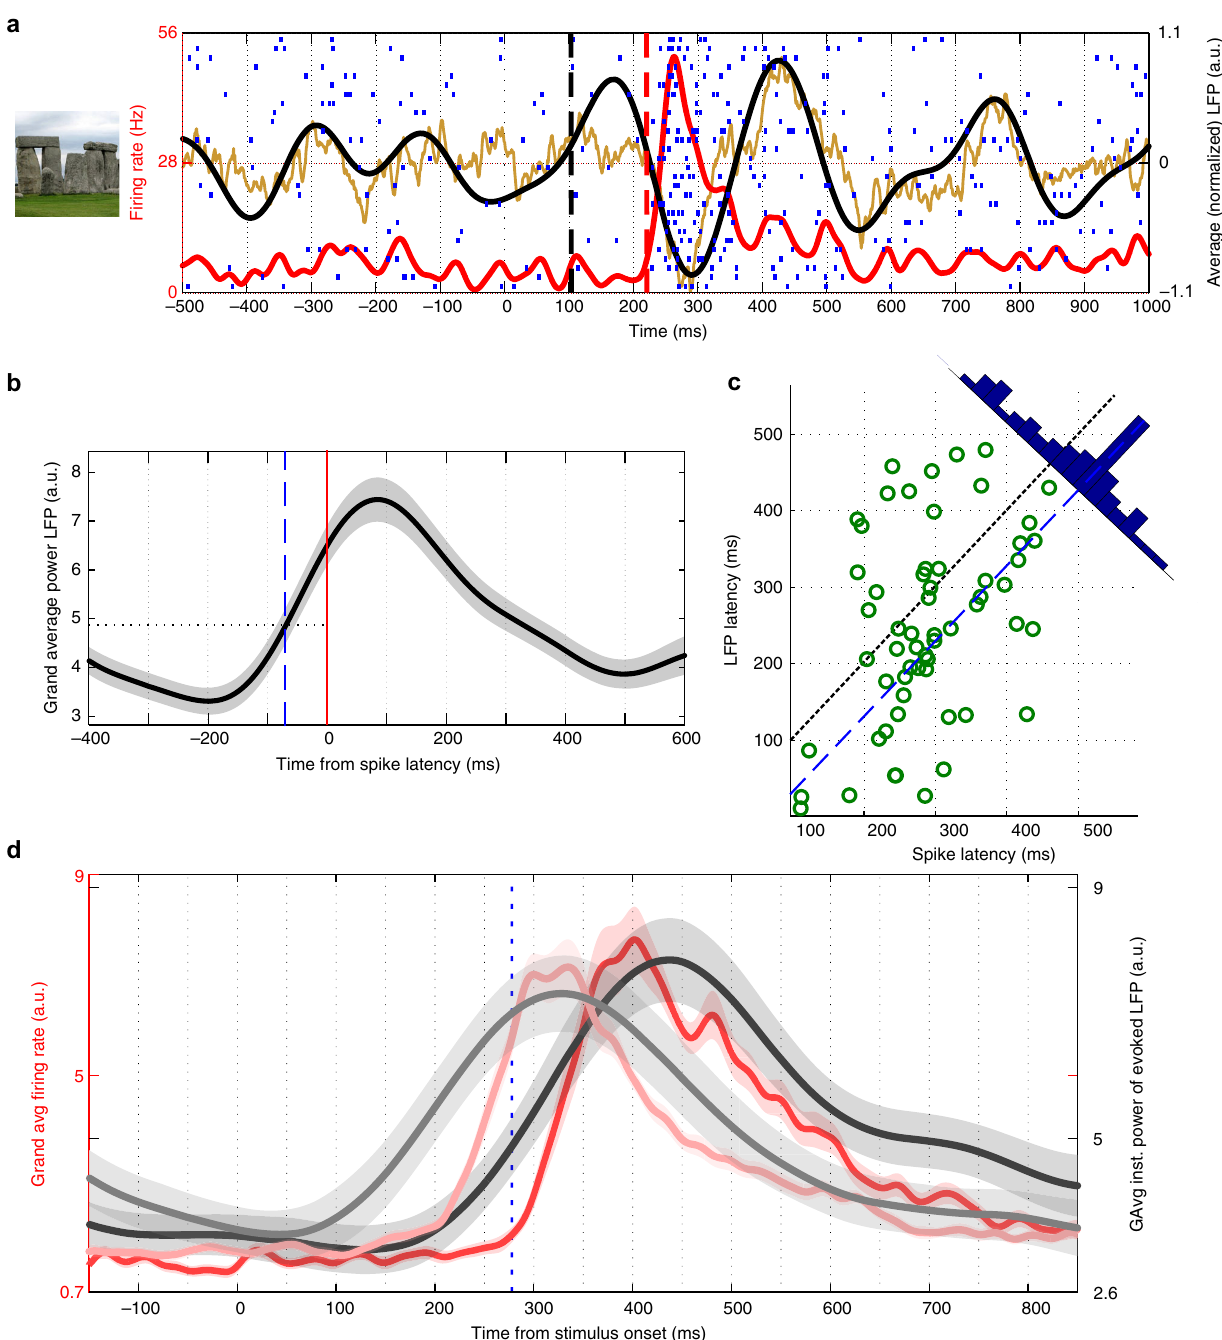
Fig. 3 LFP and spike latency analysis for individual responses. a Exemplary unit recorded in the left hippocampus that responded to the picture of Stonehenge. The red curve corresponds to the instantaneous fi ring rate, whereas the vertical dashed line marks the spike response onset. The average LFP responses are shown in brown (raw LFP: 2 to 512 Hz) and black (theta LFP: 3 to 6 Hz), with the vertical dashed line marking the LFP response onset (Methods). The spike response latency was 221 ms and the LFP onset occurred 118 ms before. Due to copyright issues, the image presented here (cropped from “ Stonehenge 02 ” by Bernard Gagnon, licensed under CC BY-SA 3.0) is similar to the one actually presented to the subject. b Latency corrected average of the 151 theta LFP responses. The LFP traces of the individual responses are aligned to the spike latency before computing the grand average. The blue dashed line marks 70 ms before the spike latency. c LFP and spike latencies for individual responses were signi fi cantly correlated (Pearson correlation, r = 0.35, p = 4 × 10 − 3 ). Points were projected into the orthogonal direction to y = x (black dashed line) and their distribution shows a clear peak. The blue dashed line represents y = x − 70. d Grand average of the instantaneous fi ring rate (red) and the theta LFP (black) for the “ early ” (light traces) and “ late ” (dark traces) subsets of responses, which were split with respect to the median spike latency (278 ms, blue dashed line). The peak LFP latency was signi fi cantly different for the early and late groups (one-sided rank-sum test, p = 3 × 10 − 3 ) and for both groups the LFP responses preceded the ones of the